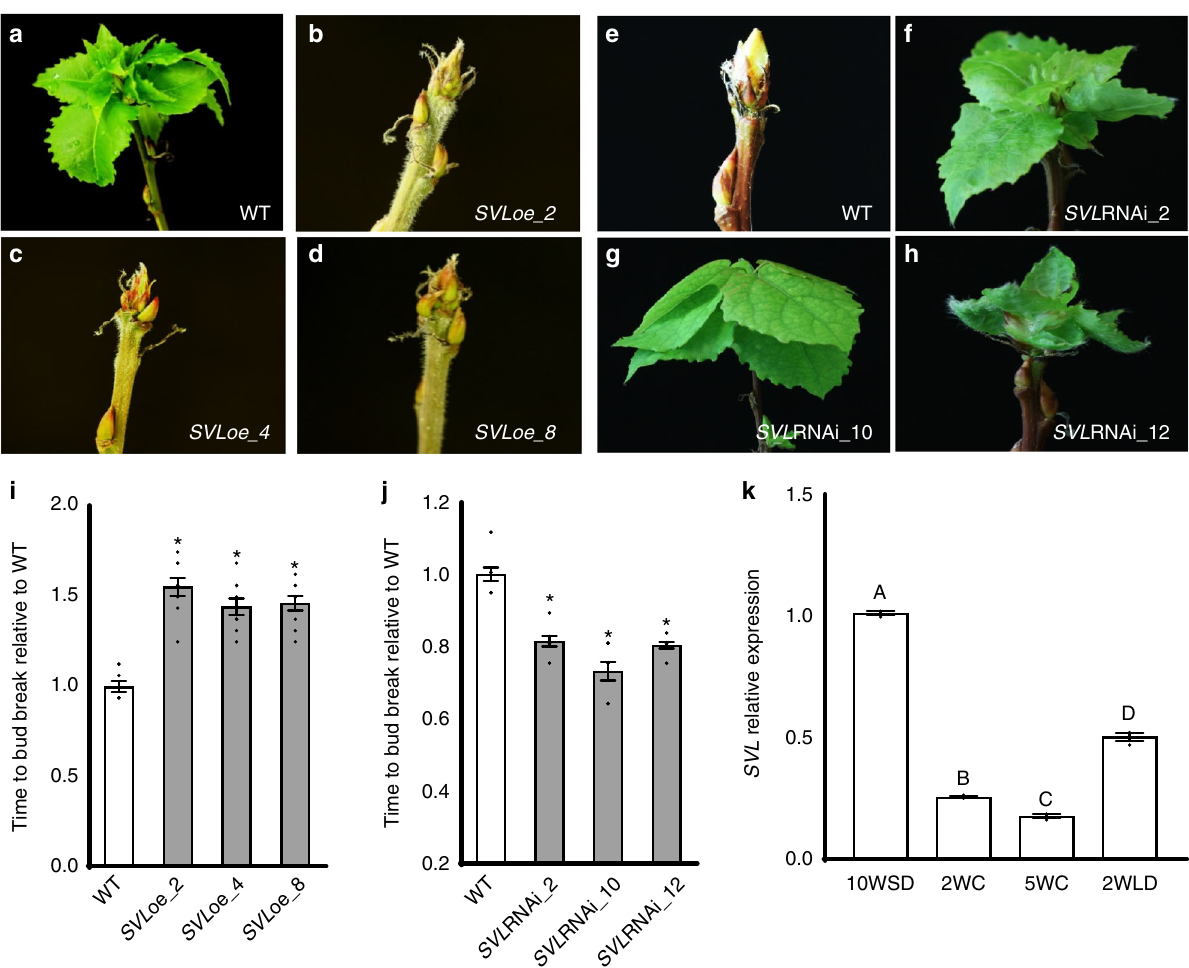
Fig. 1 Delayed and early bud break in plants over- and under-expressing SVL . a – d Bud break is earlier in a WT plants than in three independent SVL overexpressing lines, designated SVL oe2 b , SVL oe4 c , and SVL oe8 d . e – h In contrast, bud break is later in WT plants h than in independent SVL RNAi lines 2 f , 10 g , and 12 h . I , j Time to bud break relative to wild type controls in SVL oe i and SVL RNAi j lines. Average time taken to bud break ± standard error mean (SEM), with respect to WT considered as 1, is shown with data from 10 plants from each line. Asterisks (*) indicate signi fi cant differences ( P < 0.05) with respect to WT. k Low temperatures suppress SVL expression. Relative expression of SVL after 10 weeks of SD, followed by 2 and 5 weeks of low temperature (2WC, 5WC at + 4 °C) and after 2 weeks subsequent exposure to long days and warmer temperatures (2WLD). SVL expression from three independent biological replicates ± SEM is shown relative to the reference gene UBQ with 10WSD time point set to 1. Different letters A – D over the bars indicate signi fi cant differences at P < 0.001. Statistical analysis was done using one way ANNOVA implying Dunnett ’ s/Tukey ’ s multiple comparison